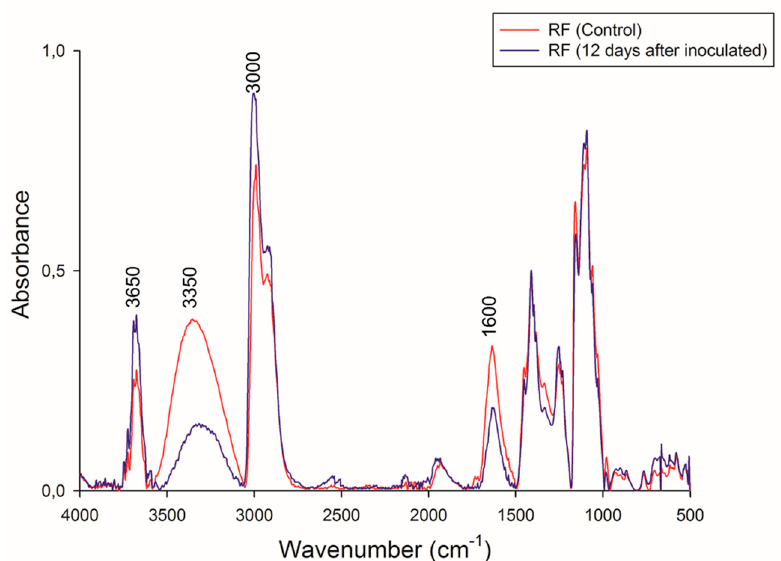
Figure 7. FT-IR spectral of initial and final biomass. Red line: RF control, and black line: residual RF 12 days.